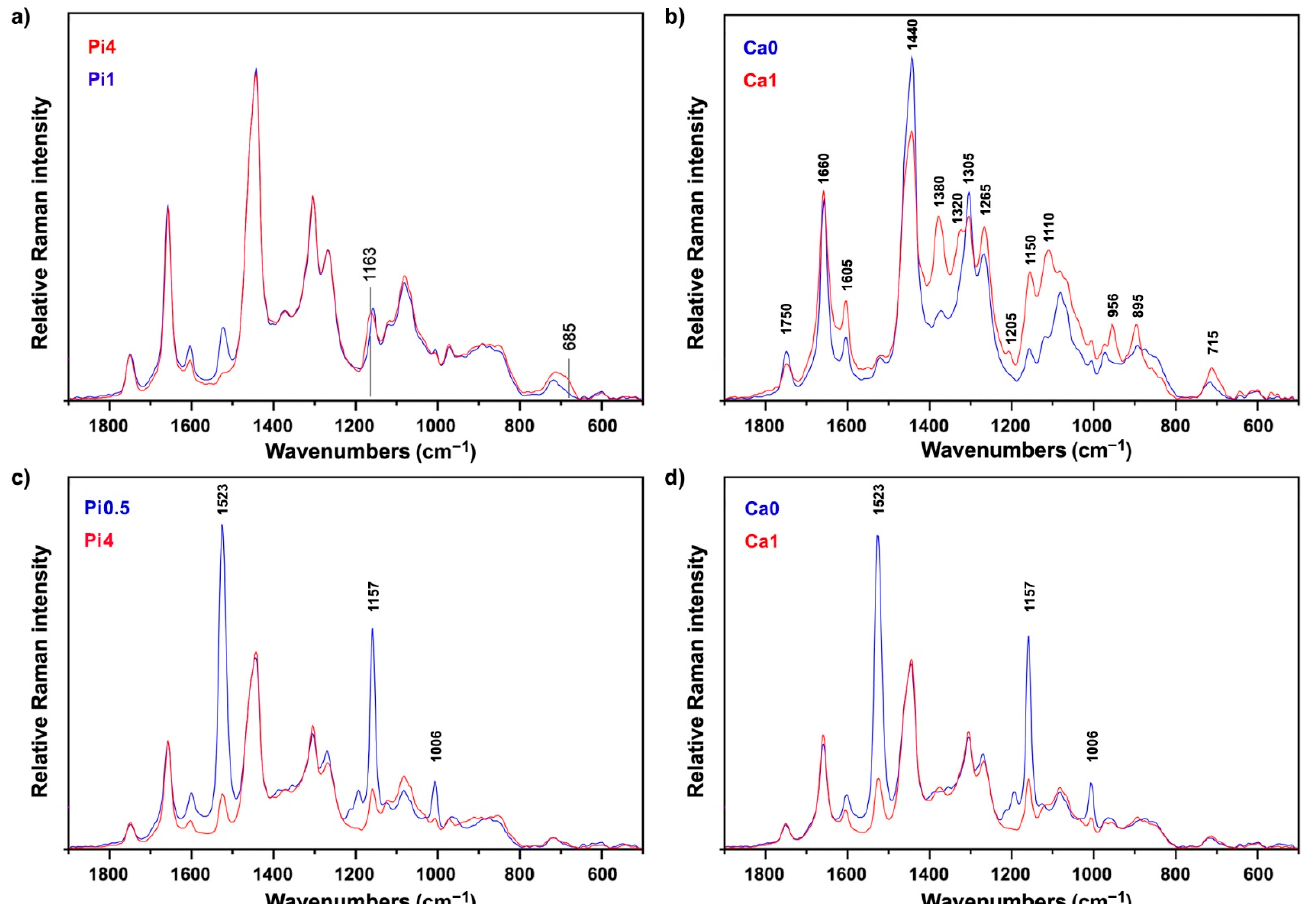
Figure 6. Influence of growth conditions on FT-Raman spectra of fungal biomass. Preprocessed FT-Raman spectra of: ( a ) Mucor circinelloides strain VI 04473 cultivated under reference calcium condition (Ca1) and two different phosphate concentrations, ( b ) Mucor circinelloides strain VI 04473 cultivated under low phosphates (Pi0.5) and two different calcium conditions (Ca0 and Ca1), ( c ) Mucor circinelloides strain FRR 5020 cultivated under absence of calcium (Ca0) and two different phosphate conditions (Pi0.5 and Pi4), and ( d ) Mucor circinelloides strain FRR 5020 cultivated under low phosphates (Pi0.5) and two different calcium conditions (Ca0 and Ca1).